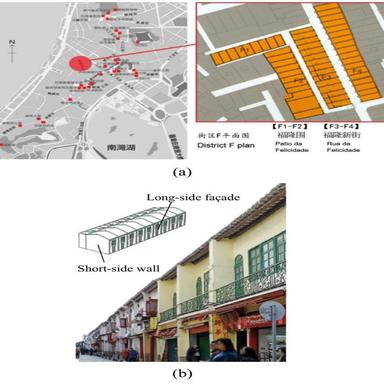
(a) District plan of the case (b) a two-story masonry building in Rua da Felicidade.